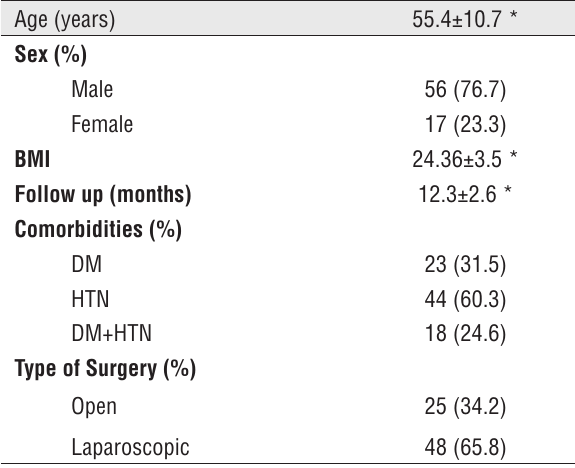
Table 1 - Baseline characteristics of